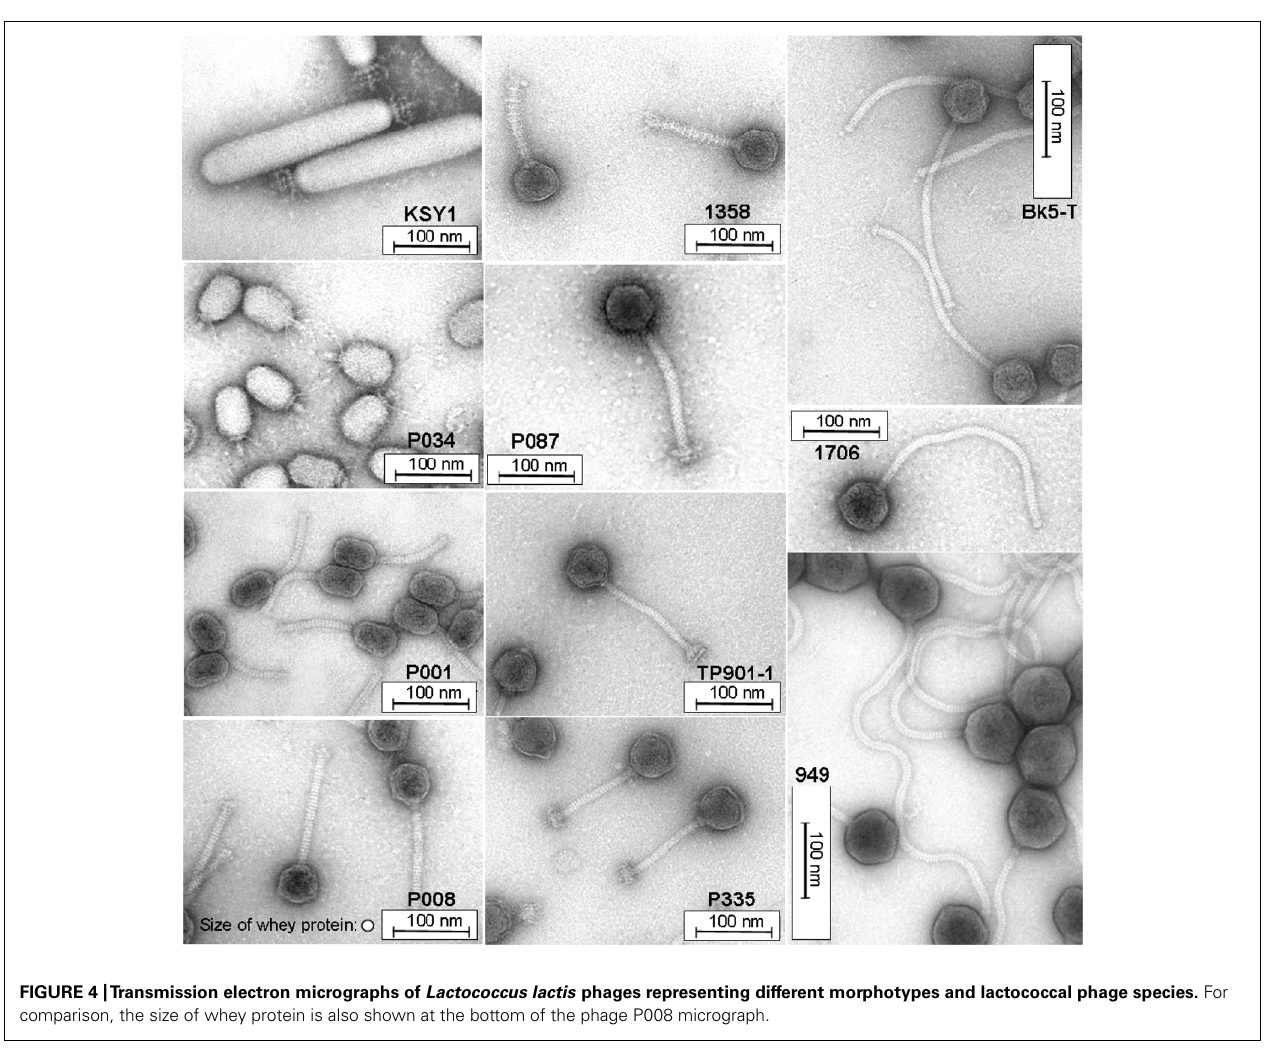
FIGURE 4 |Transmission electron micrographs of Lactococcus lactis phages representing different morphotypes and lactococcal phage species. For comparison, the size of whey protein is also shown at the bottom of the phage P008 micrograph.